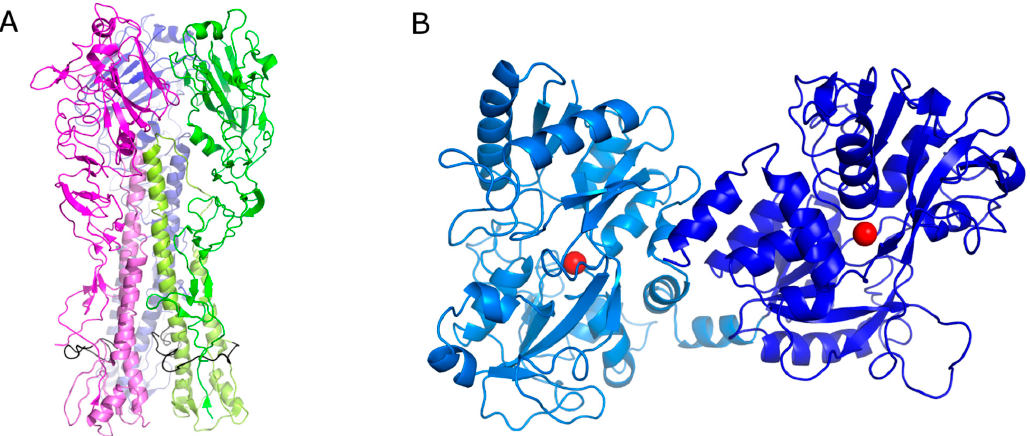
Figure 1. ( A ) Cartoon representation of the hemagglutinin (HA) trimeric protein. Each monomer has a different color. The HA 1 chain has been depicted with a dark color and HA 2 with a pale color. The fusion peptide is represented in black. ( B ) Cartoon representation of bovine lactoferrin (bLf). The